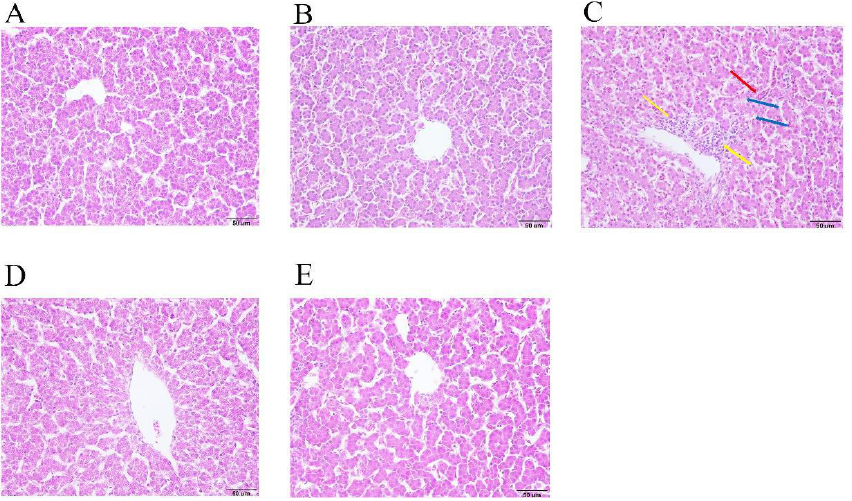
Figure 4. GA alleviated MG infection-induced liver damage in broilers. ( A ) control group, ( B ) GA- alone treatment group, ( C ) model group, ( D ) Tia therapy group, ( E ) GA therapy group. Yellow arrows show inflammatory cell infiltration around the central veins, blue arrows show vacuolar degeneration and red arrows show sinus congestion.